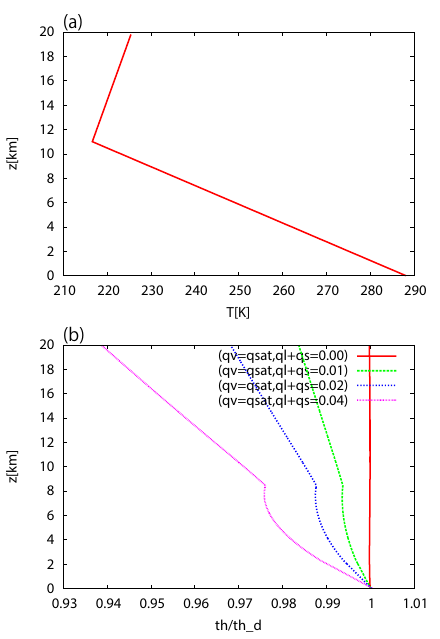
Figure A1. Vertical profile of (a) US standard atmosphere; (b) sev- eral profiles of θ/θ d